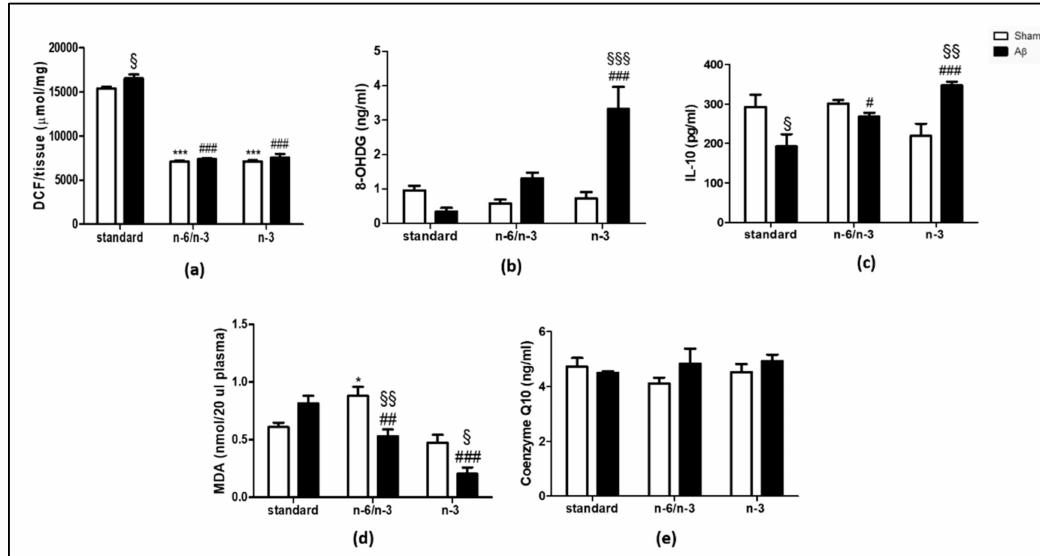
Figure 1. Effects of standard, n-6/n-3 PUFA balanced and n-3 PUFA enriched diets on hippocampal ROS production, 8-OHdG and IL-10 levels, plasmatic MDA, and CoQ10 content in A β -treated rats. Measure of hippocampal ROS production ( a , SHAM standard n = 3, A β standard n = 4, SHAM n-6/n-3 n = 4, A β n-6/n-3 n = 4, SHAM n-3 n = 4, A β n-3 n = 4 ), 8-OHdG ( b , SHAM standard n = 4, A β standard n = 4, SHAM n-6/n-3 n = 4, A β n-6/n-3 n = 4, SHAM n-3 n = 4, A β n-3 n = 4), IL-10 ( c , SHAM standard n = 4, A β standard n = 4, SHAM n-6/n-3 n = 4, A β n-6/n-3 n = 4, SHAM n-3 n = 3, A β n-3 n = 4 ), plasmatic MDA levels ( d , SHAM standard n = 4, A β standard n = 4, SHAM n-6/n-3 n = 3, A β n-6/n-3 n = 4, SHAM n-3 n = 5, A β n-3 n = 4 ) in rats 7 days after A β icv injection (A β , 4 µ M, black bar) or vehicle (SHAM, 5 µ L vehicle, white bar) and plasmatic CoQ10 levels ( e , SHAM standard n = 4, A β standard n = 4, SHAM n-6/n-3 n = 4, A β n-6/n-3 n = 4, SHAM n-3 n = 4, A β n-3 n = 4). Two-way ANOVA followed by Bonferroni multiple comparison test, § p < 0.05, §§ p < 0.01, §§§ p < 0.001 A β -treated rats fed, either, with n-6/n-3 balanced and n-3 PUFA enriched diets versus SHAM rats; * p < 0.05, *** p < 0.001 SHAM rats fed with n-6/n-3 balanced and n-3 PUFA enriched diets versus SHAM standard diet; # p < 0.05, ## p < 0.01, ### p < 0.001 A β -treated rats fed with n-6/n-3 balanced and n-3 PUFA enriched diets versus A β , standard diet. Data were expressed as means ± mean standard error